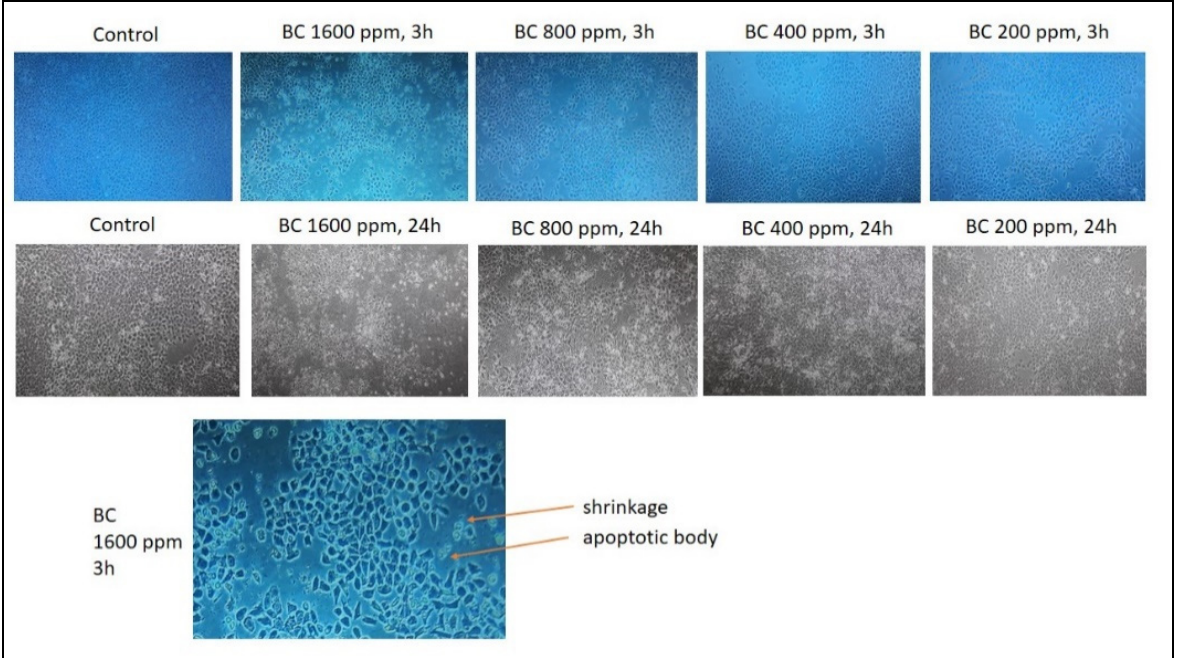
Figure 5. The application of Brenia cernua to MCF-7 cell line. Trypan blue staining was used to measure the level of cell death. Control: cancer cells treated with solvent (DMSO 0.5% v / v ). The cell morphology was observed using inverted microscopy (Agilent). Apoptotic bodies were characterized by cell shrinkage. Table 2. Binding affinity of identified compounds to selected target proteins. Nd: not